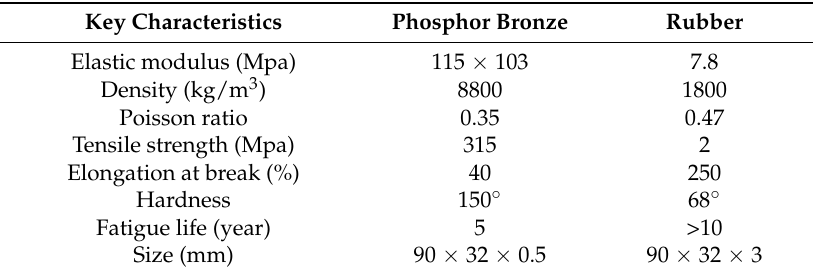
Table 3. Partial Parameters of Packaging Materials.